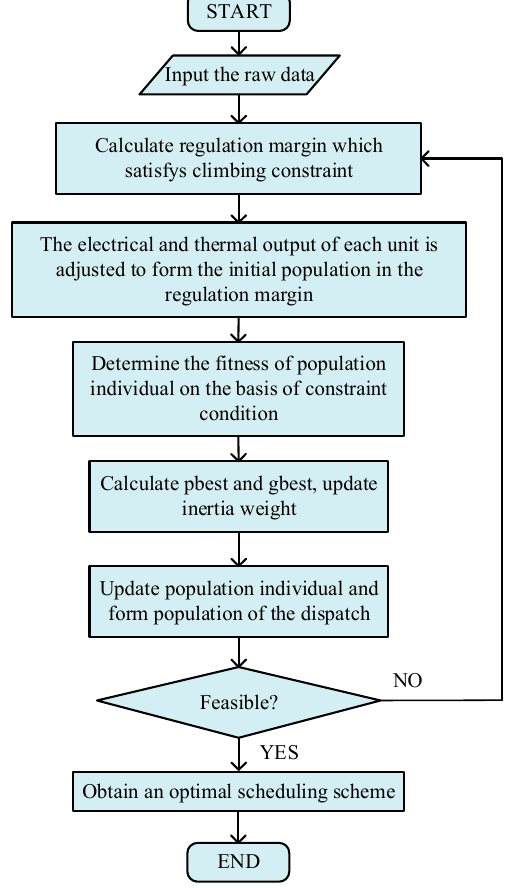
Figure 3. Flowing of solving day-ahead dispatch model with particle swarm optimization (PSO).